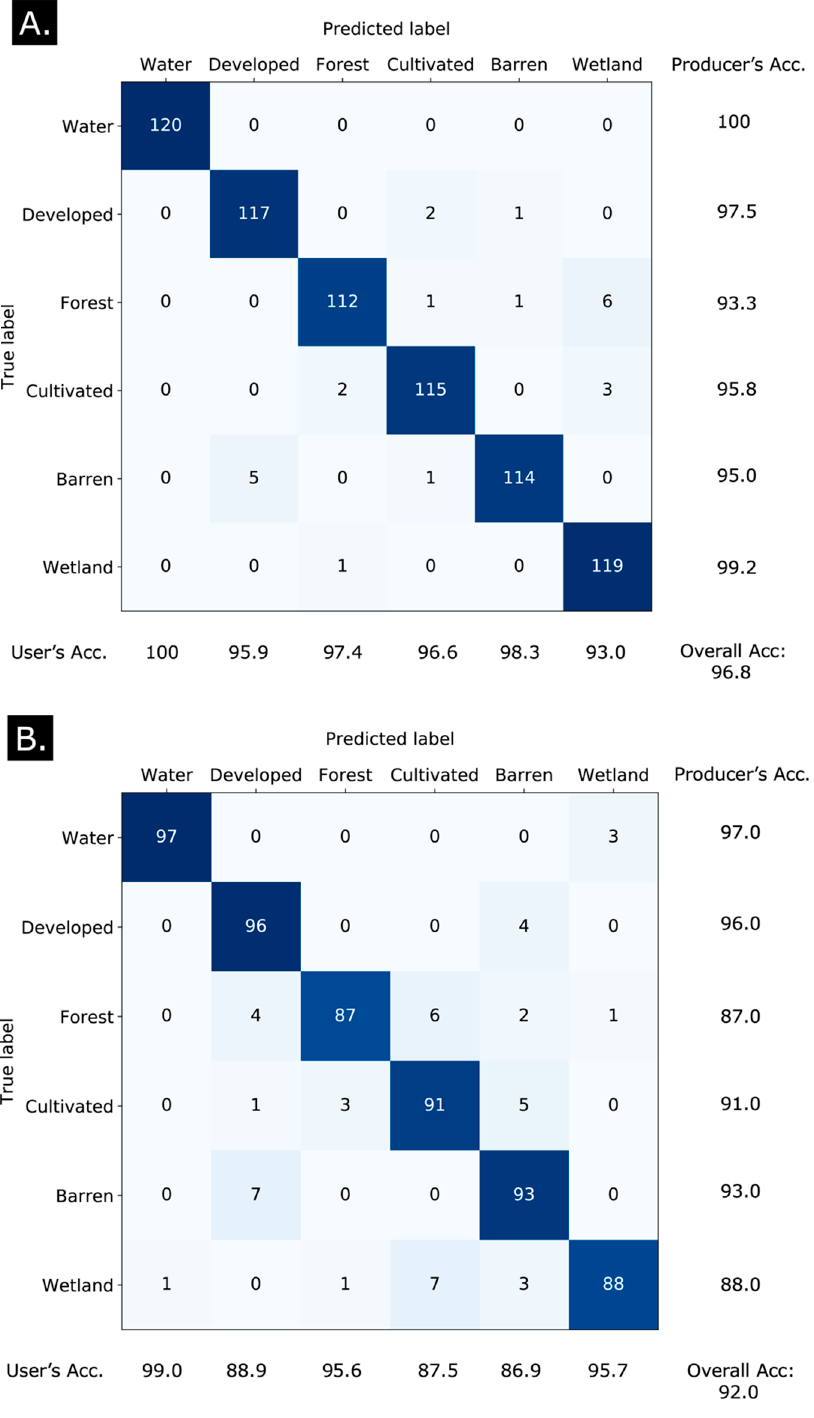
Figure 6. Confusion matrix including user’s, producer’s, and overall accuracy for the recurrent convolutional neural network on ( A ) 2011 test data and ( B ) 2000 test data. The difference in per class totals (120 vs. 100) is based on the process of generating 150 pixels per class from the NLCD dataset and then manually validating. The correct class was visually validated, mixed pixels were rejected, and then all classes were subset to the same number as the class with the least number of validation pixels.